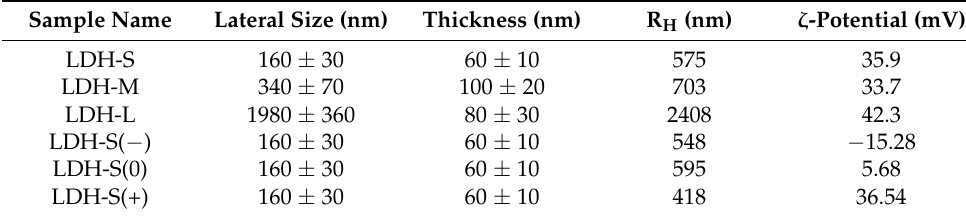
Figure 1. Scanning electron microscopic (SEM) images for ( a ) LDH-S, ( b ) LDH-M, ( c ) LDH-L, ( g ) LDH-S( − ), ( h ) LDH-S(0) and ( i ) LDH-S(+) and size distribution of ( d ) LDH-S, ( e ) LDH-M and ( f ) LDH-L. Table 1. Physicochemical parameters of the LDHs appeared in the present paper.